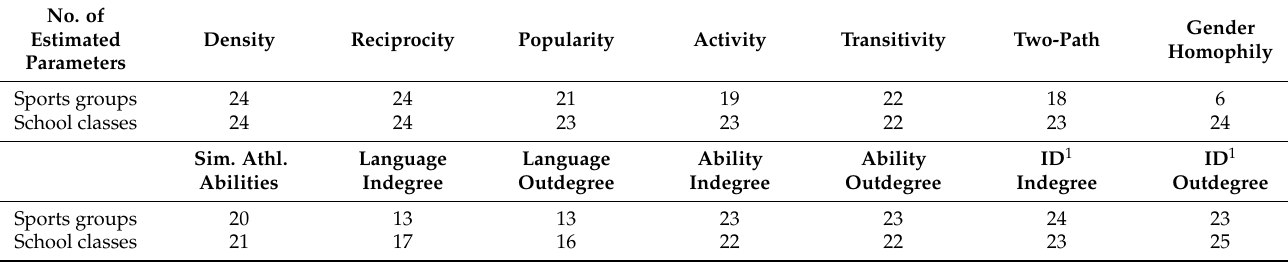
Table A1. Number of model parameters estimated for 24 full network models in integrative sports groups and school classes for meta-analyses.